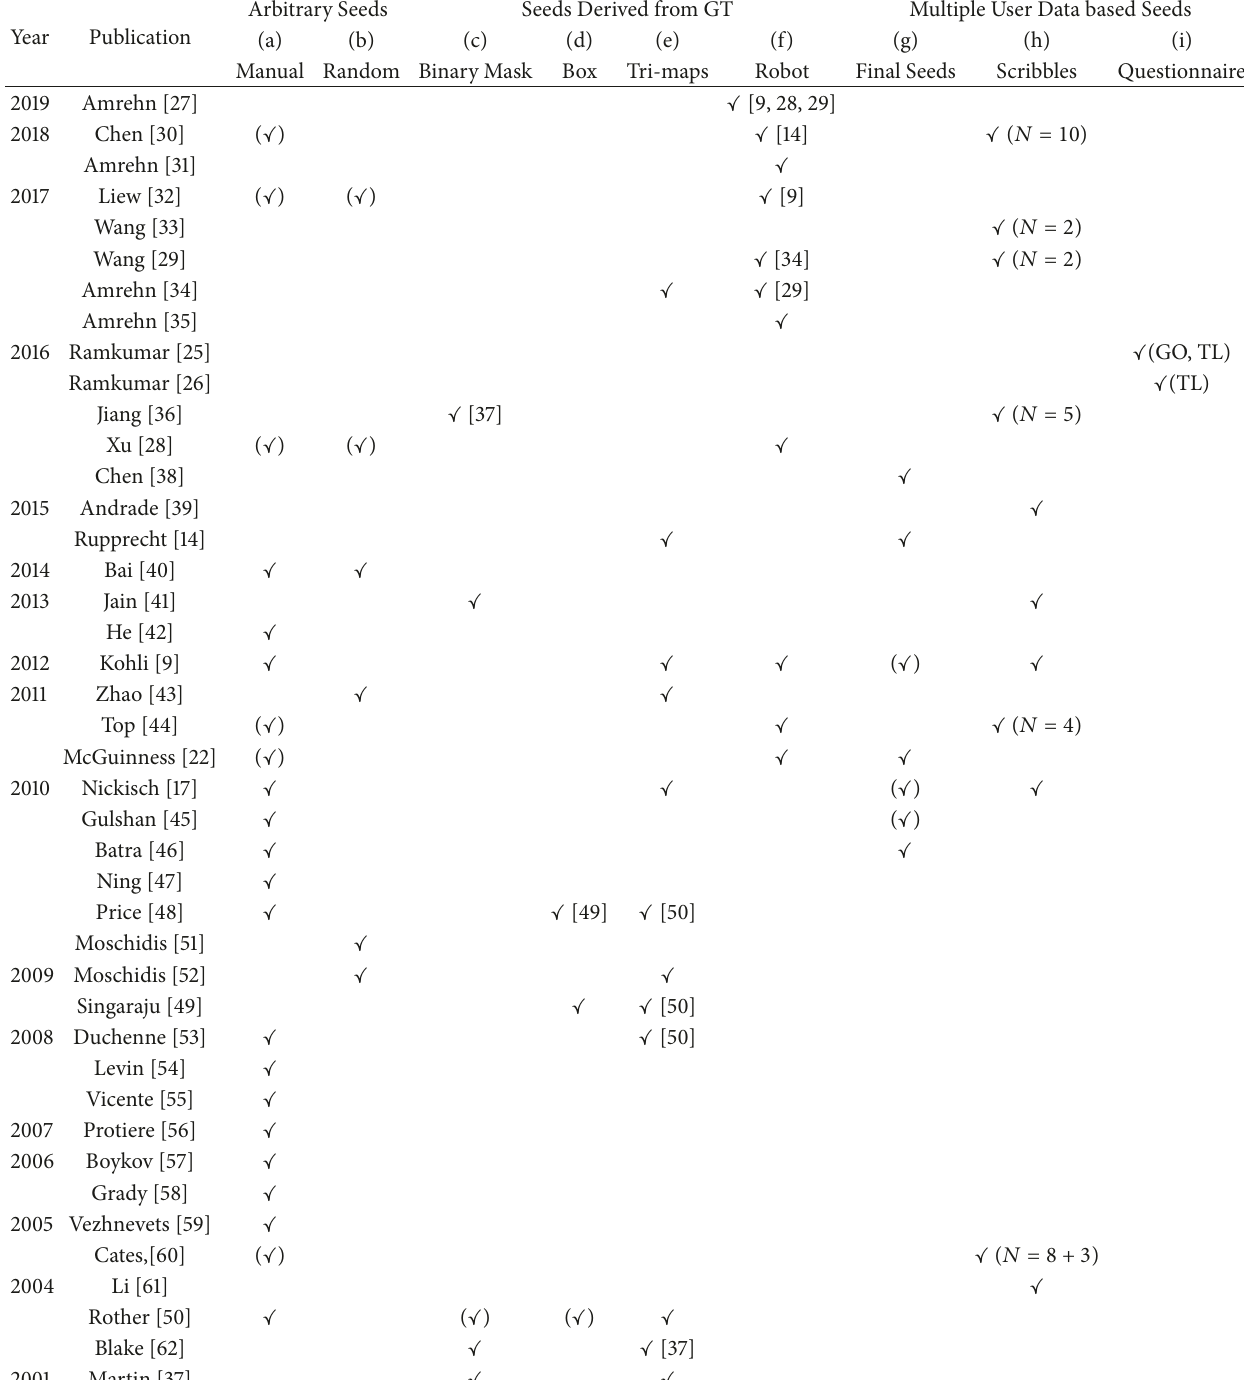
Table 1: Overview of seed point location selection methods for a set of influential publications in the field of interactive image segmentation. Additional unordered seed information can be retrieved in arbitrary order by (a) manually drawn seeds or (b) randomly generated seeds. Seeds can be inferred rule-based from the ground truth segmentation by (c) sampling the binary mask image, (d) from provided bounding box mask images, (e) random sampling from tri-maps generated by erosion and dilation, or (f) by a robot user, i.e. user simulation. A tri-map specifies background, foreground, and mixed areas. Seeds can also be provided by real users via the (g) final seed masks after all interactions on one input image or (h) the ordered iterative scribbles. (i) Questionnaire data from Goals, Operators, Methods, and Selection rules (GO) as well as National Aeronautics and Space Administration Task Load Index (TL) may be retrieved by interviewing users after the segmentation process. Check marks indicate the usage of seeds in the publications listed. Publications with check marks in brackets display these seeds but do not utilize them for